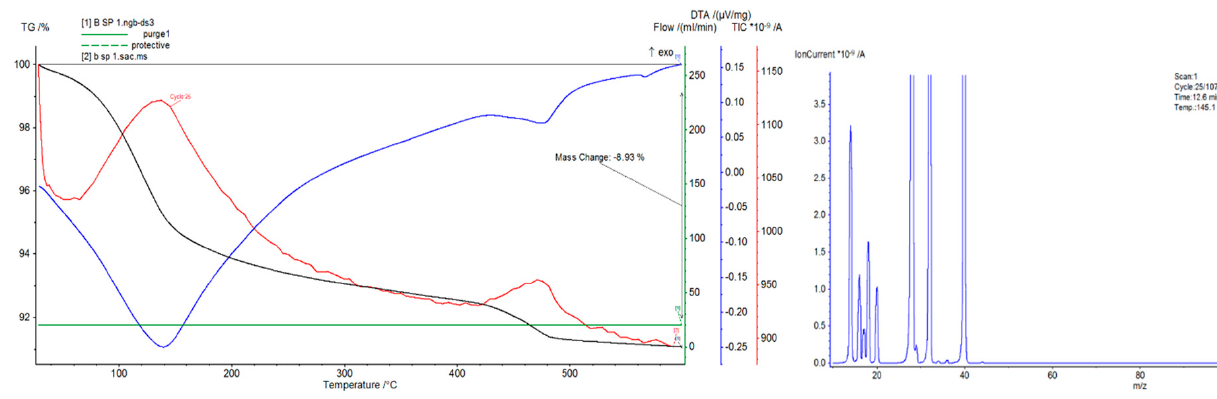
Figure 8. Thermal analysis DTA/DSC of sample 5.